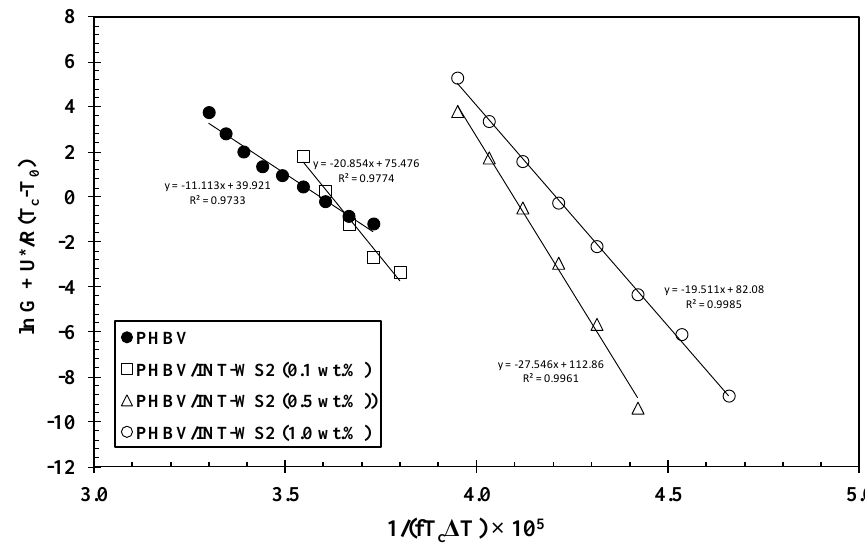
Figure 6. Logarithmic plots of Lauritzen and Hoffman (L–H) equation for PHBV/INT-WS 2 nanocomposites.